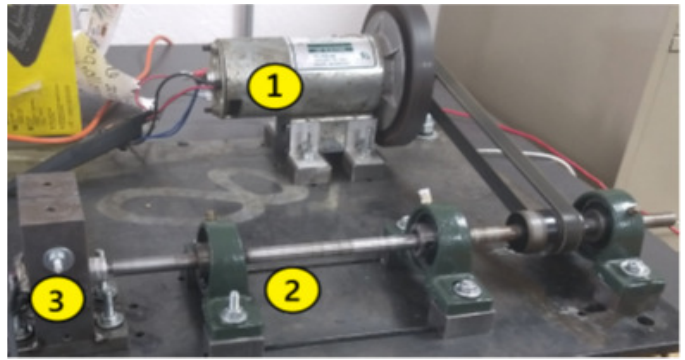
Figure 1. Laboratory prototype.